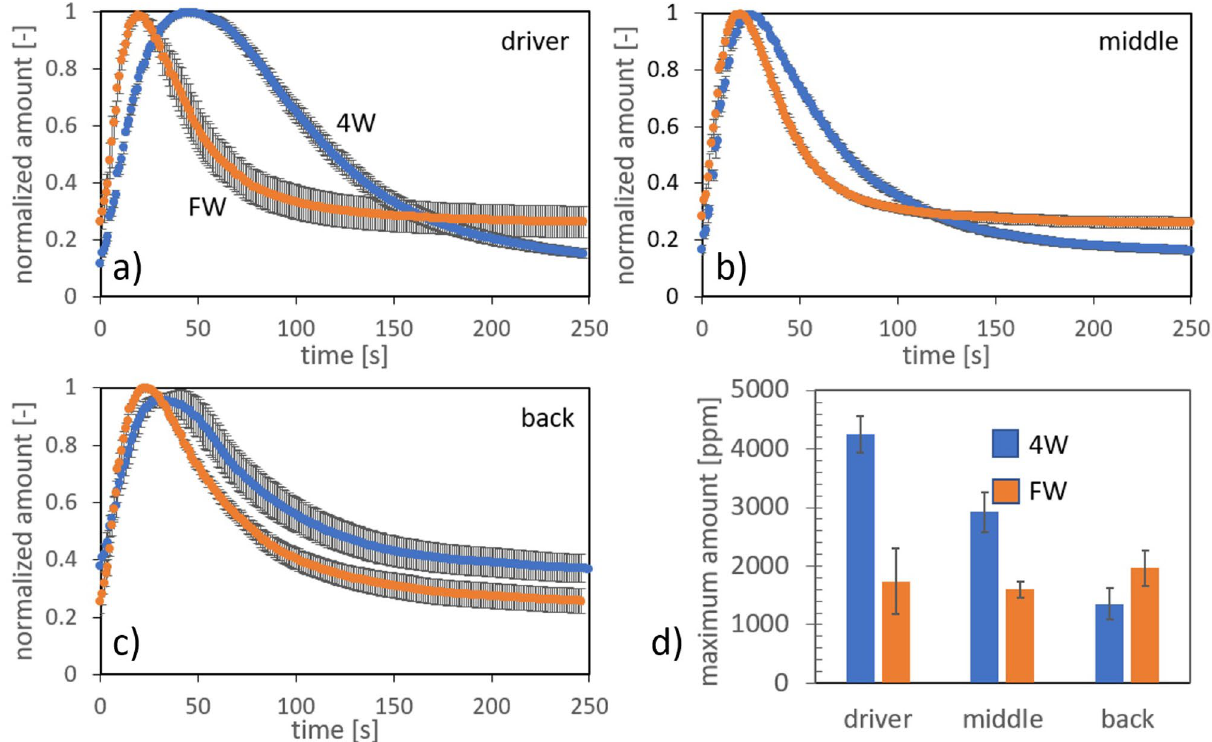
Figure 6. Ventilation experiments using CO 2 as the passive tracer in a occupied bus. ( a )–( c ): CO 2 concentration normalized with the maximum value at the emission peak as a function of time measured at the front (driver’s area), middle and back areas of the bus, respectively, for the 4W (blue line) and FW (orange line) configurations; ( d ): absolute CO 2 concentration detected at the emission peak for each case. Error bars are indicated for 5 repetitions done for each